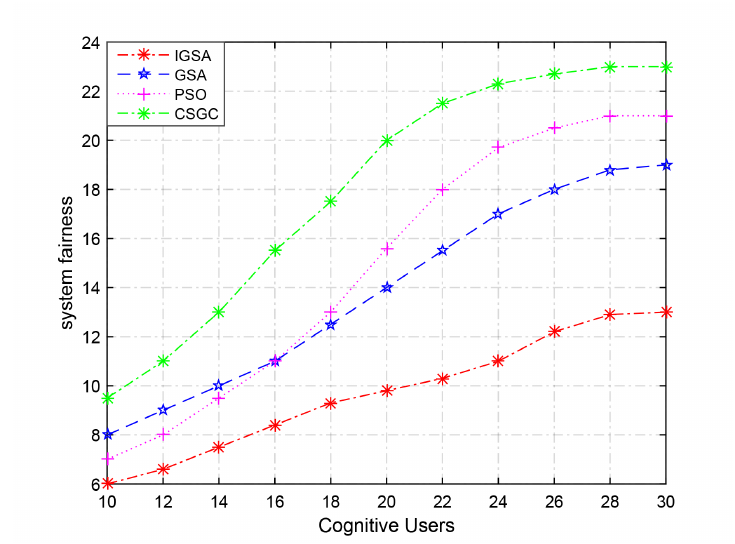
Figure 5. The system fairness trend when M = 10.